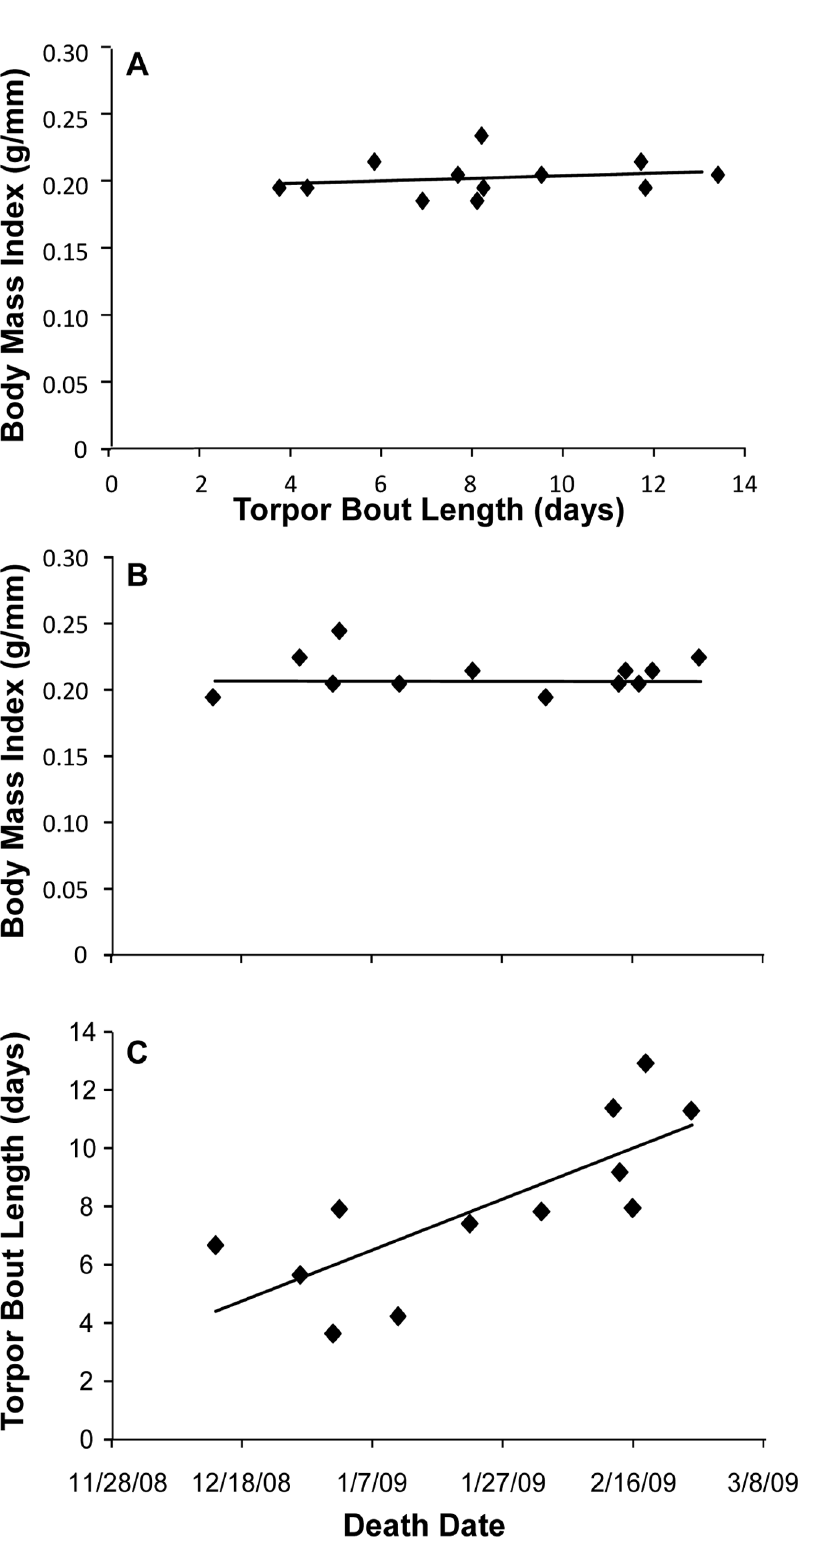
Figure 3. Torpor bout length (TBL) as a function of date of death and BMI. For the 12 bats that died from WNS, BMI at the beginning of hibernation was not related to TBL (3A), nor was BMI predictive of the date of death (3B). However, TBL significantly predicted date of death in WNS- affected bats that were found dead at the time of datalogger retrieval (3C) (r 2 =0.58). Bats that died sooner were arousing to euthermic temperatures much more frequently than those that lived longer.